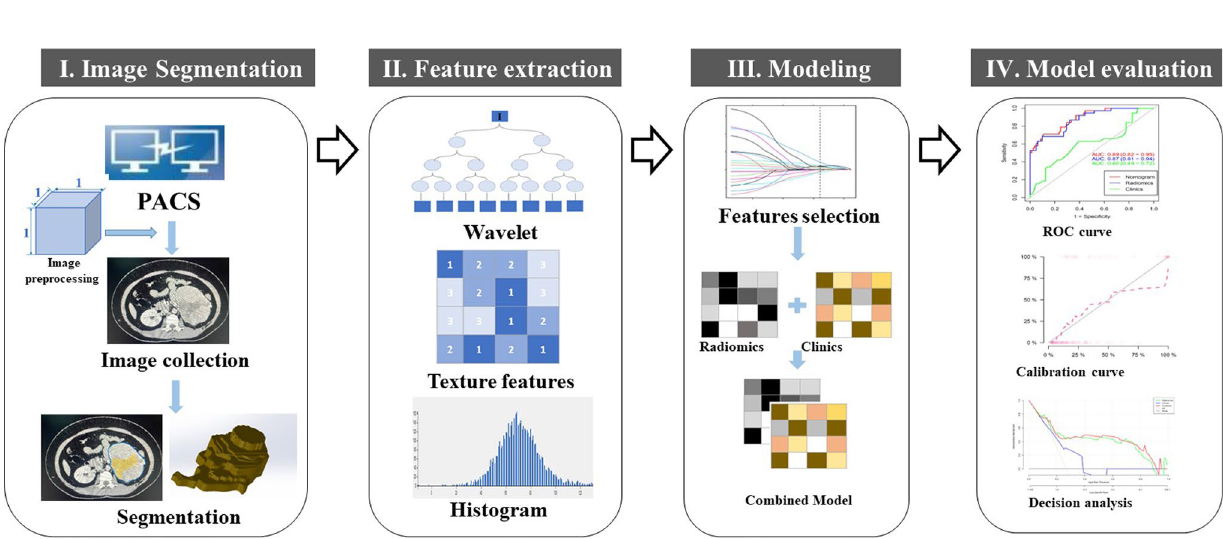
Fig. 2 Flowchart showing workflow of radiomics for adrenal incidentaloma. I. Imaging segmentation. II. Features extraction. III. Modeling. IV. Model performance evaluation by receiver operating characteristic (ROC) curve, calibration curve, and decision curve